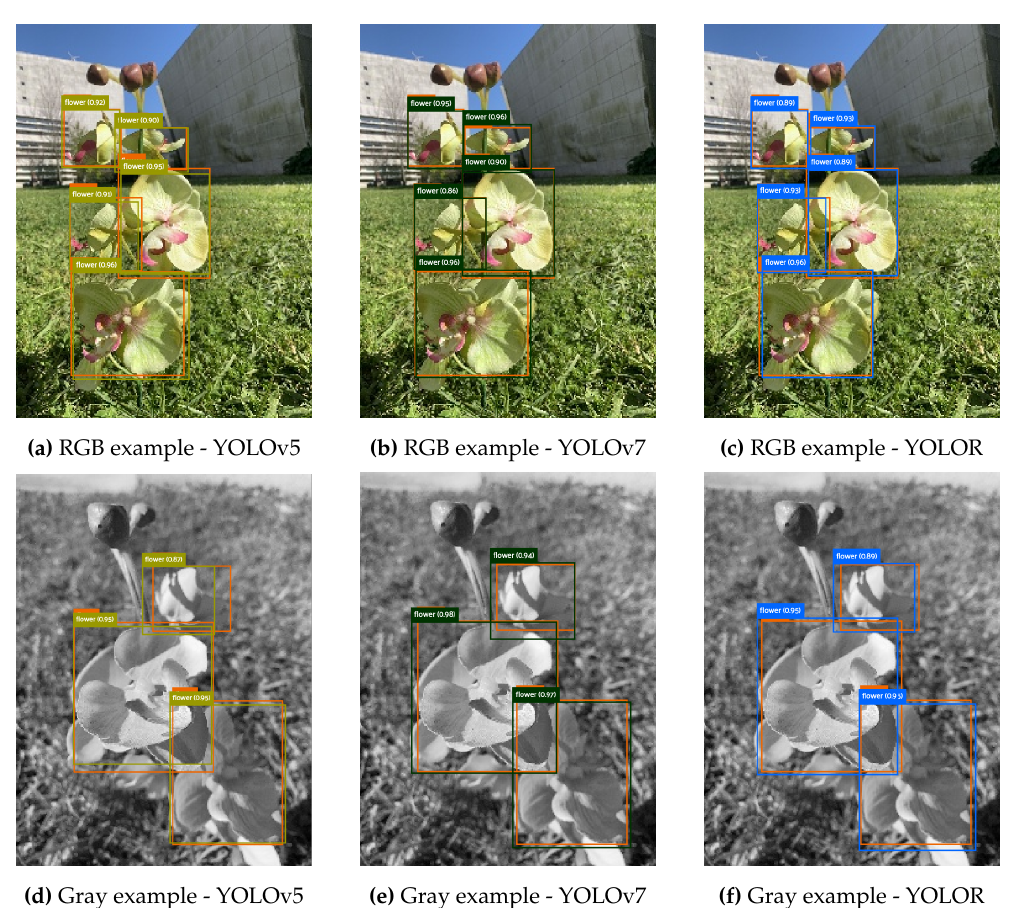
Figure 7. Detection of flowers in sample images from the test set of the Flower Detection Dataset. ( a – c ) RGB example and ( d – f ) grayscale example. Orange bounding boxes present ground truth. Light green bounding boxes present the predictions from YOLOv5. Dark green bounding boxes present the predictions from YOLOv7. Blue bounding boxes present the predictions from